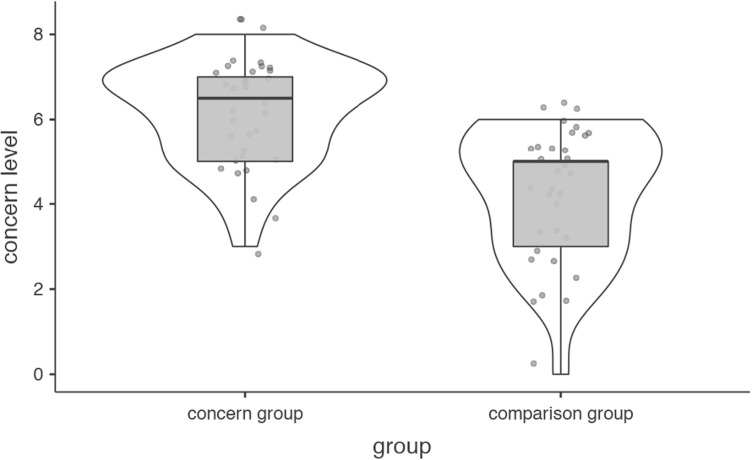
Parents’ concern level.